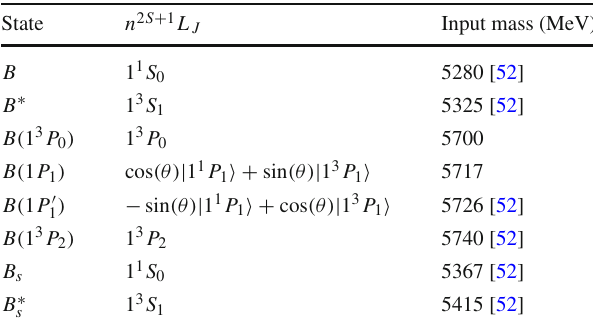
Table 18 The mass values of the bottom and bottom-strange mesons involved in the present calculation. Because of the tiny measured mass difference between B ± and B 0 , we use the experimental mass of B 0 as an input, i.e., B ( 1 1 S 0 ) meson State n 2 S + 1 L J Input mass (MeV) 1 1 S